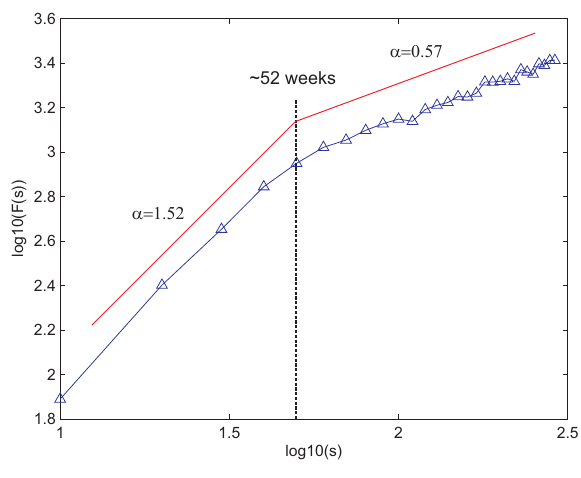
Figure 5. DFA for the reservoir water level (weekly) at Belesar.